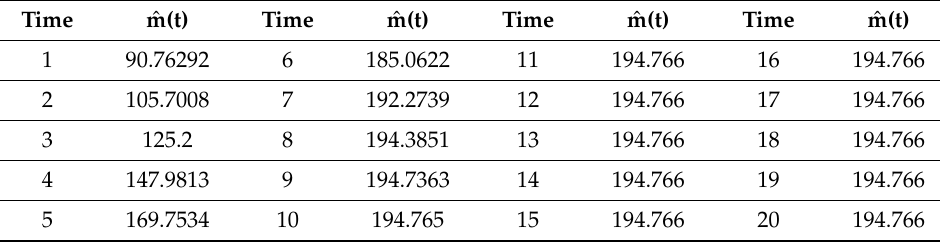
Table 7. Predicted values by proposed model for dataset